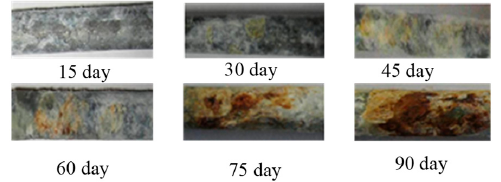
Figure 3. Corrosion of test piece.